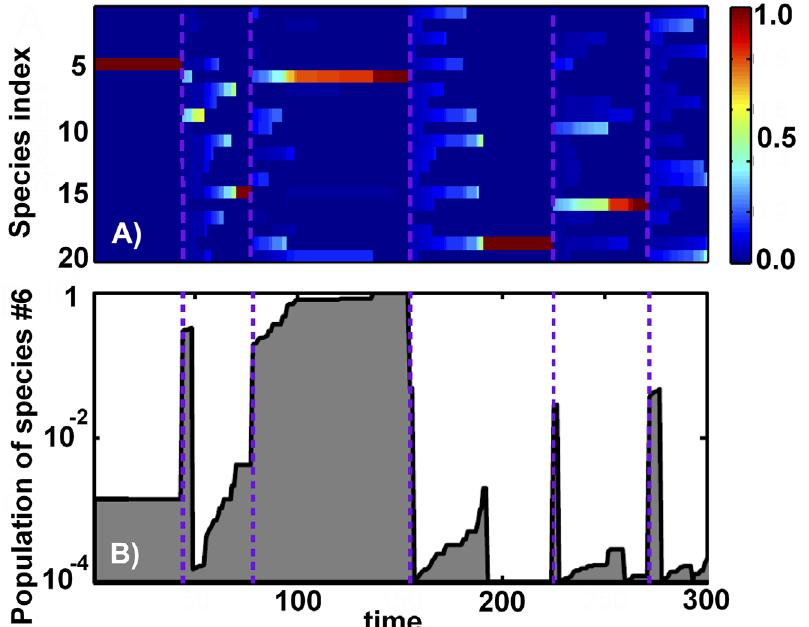
Fig 1. Population dynamics. The simulated model has N = 20 species and γ = 10 − 4 . (A) Time-courses of populations of all species. The color denotes population size (see the color scale on the right) with the dominating species visible as red horizontal bands. Note five diversity waves ending at purple dashed lines. Transitions between these waves were triggered by extinctions of the dominating species # 5, 15, 6, 19, 16 correspondingly. (B) The time-course of the species # 6 with the logarithmic y-axis. Note the pattern of intermittent periods of exponential growth fueled by local extinctions.